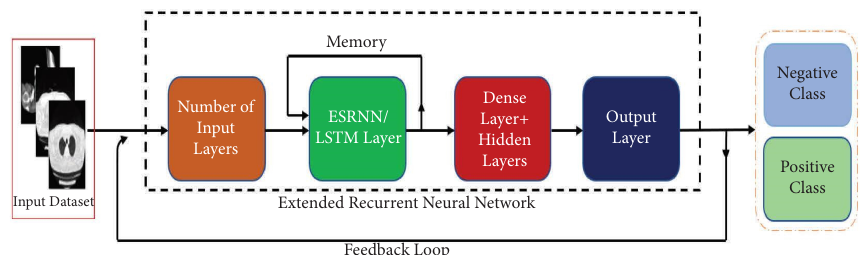
Figure 2: Workfow diagram of the proposed model utilizing the ERNN technique.